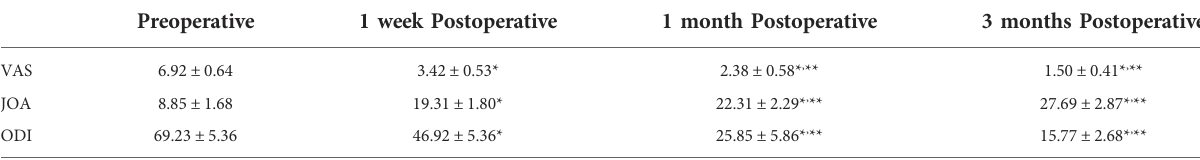
TABLE 2 The variation in visual analog scale (VAS), Japanese Orthopaedic Association (JOA), and Oswestry Disability Index (ODI) preoperatively and postoperatively ( x ± s , points).